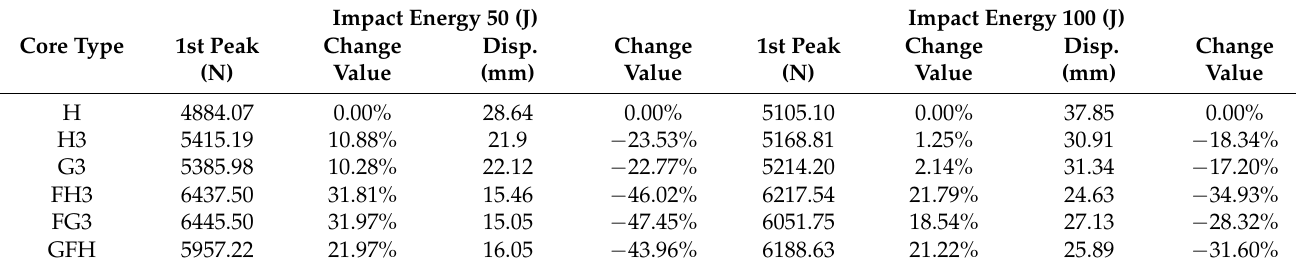
Table 5. Change values of sandwich panels under flat impactor.